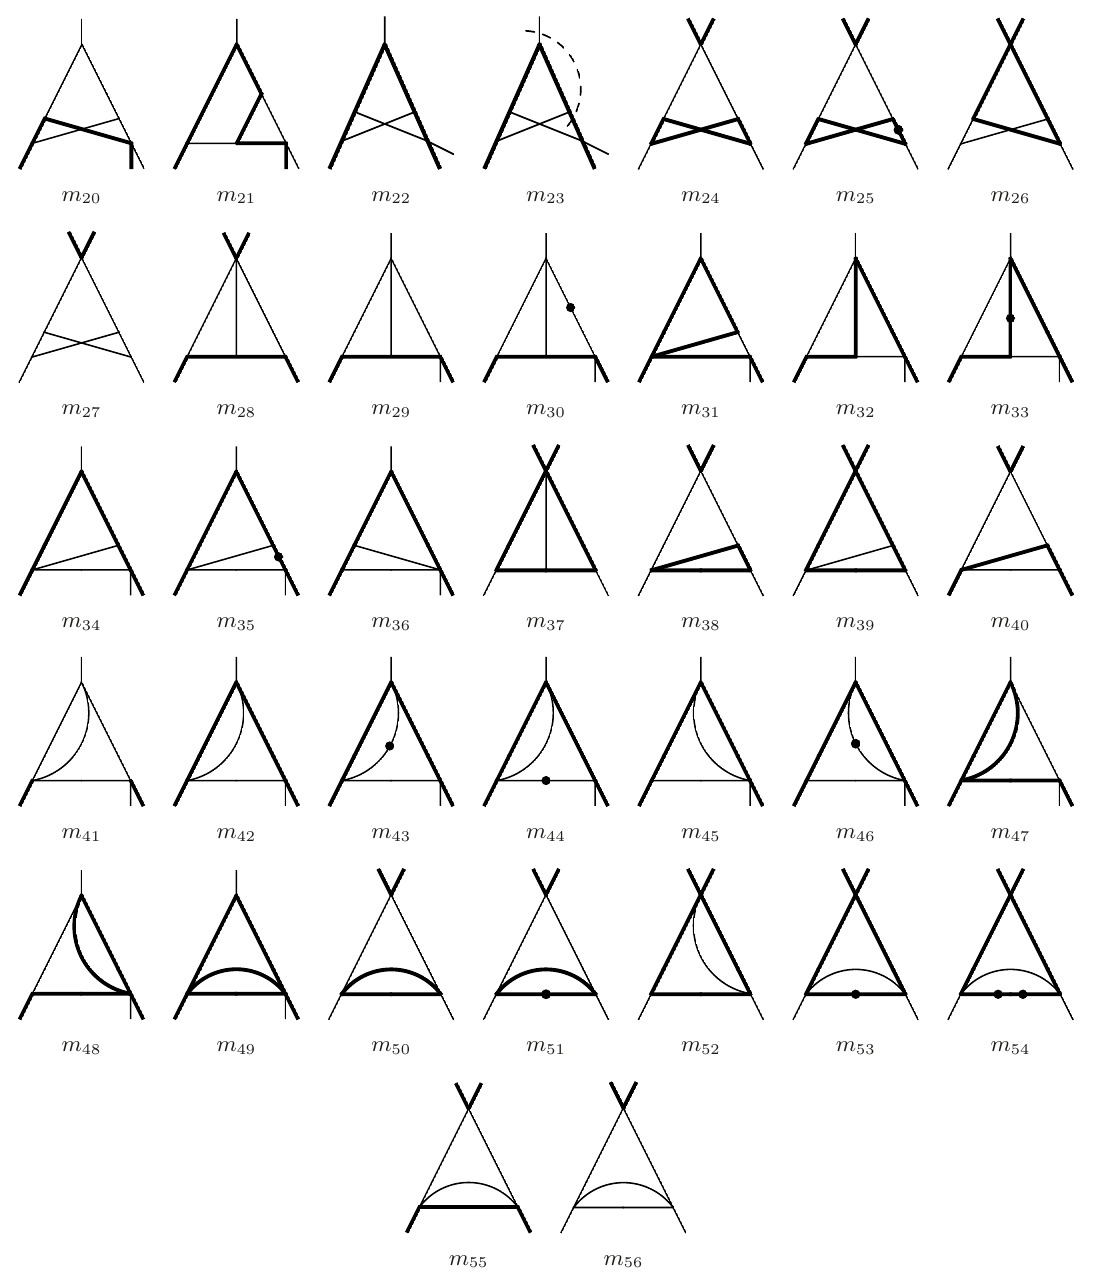
Figure 2. Three-point non-factorisable two-loop integrals. Thin lines are massless, and thick lines have mass m Q . A dot on a propagator means that the propagator is squared. The dashed line on m 23 denotes a numerator, see section A for the explicit